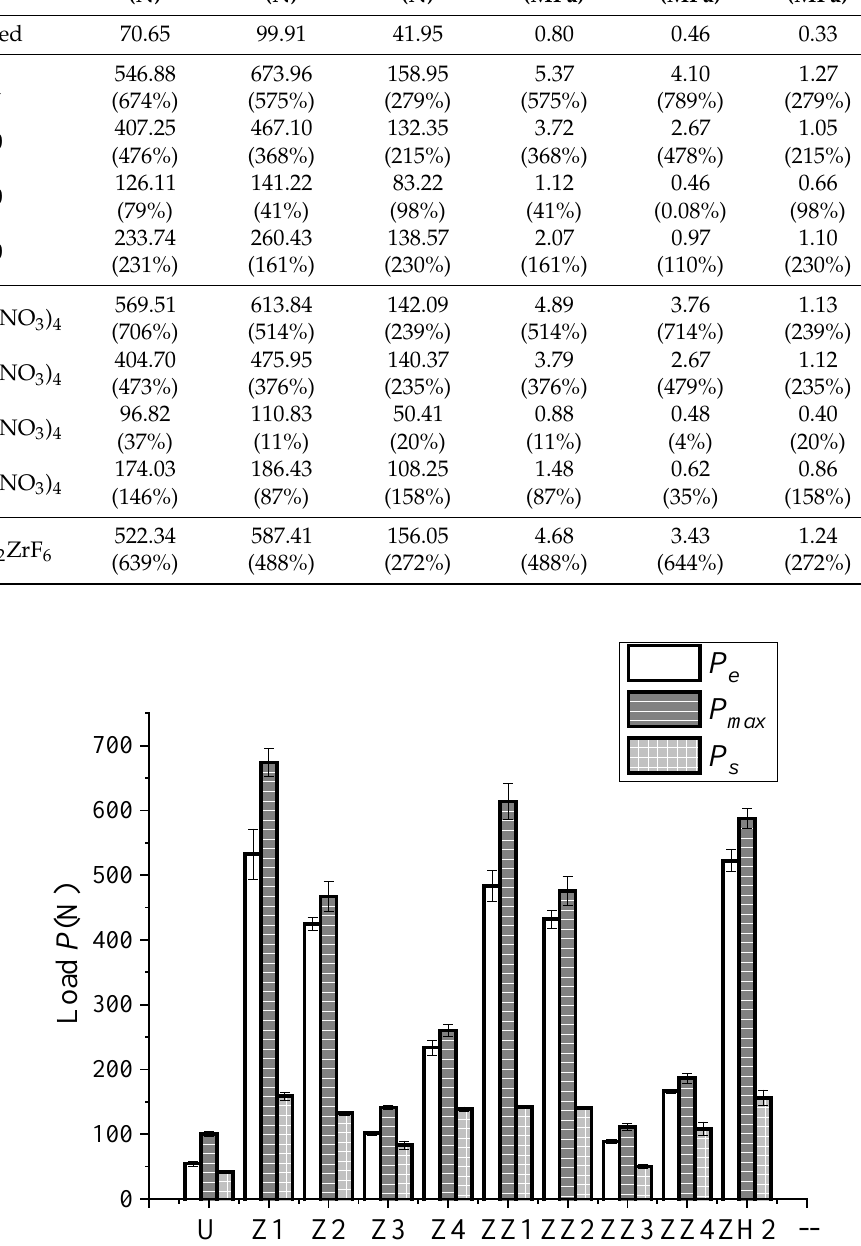
Figure 8. Bonding strengths ( τ max = τ c + τ s ). U